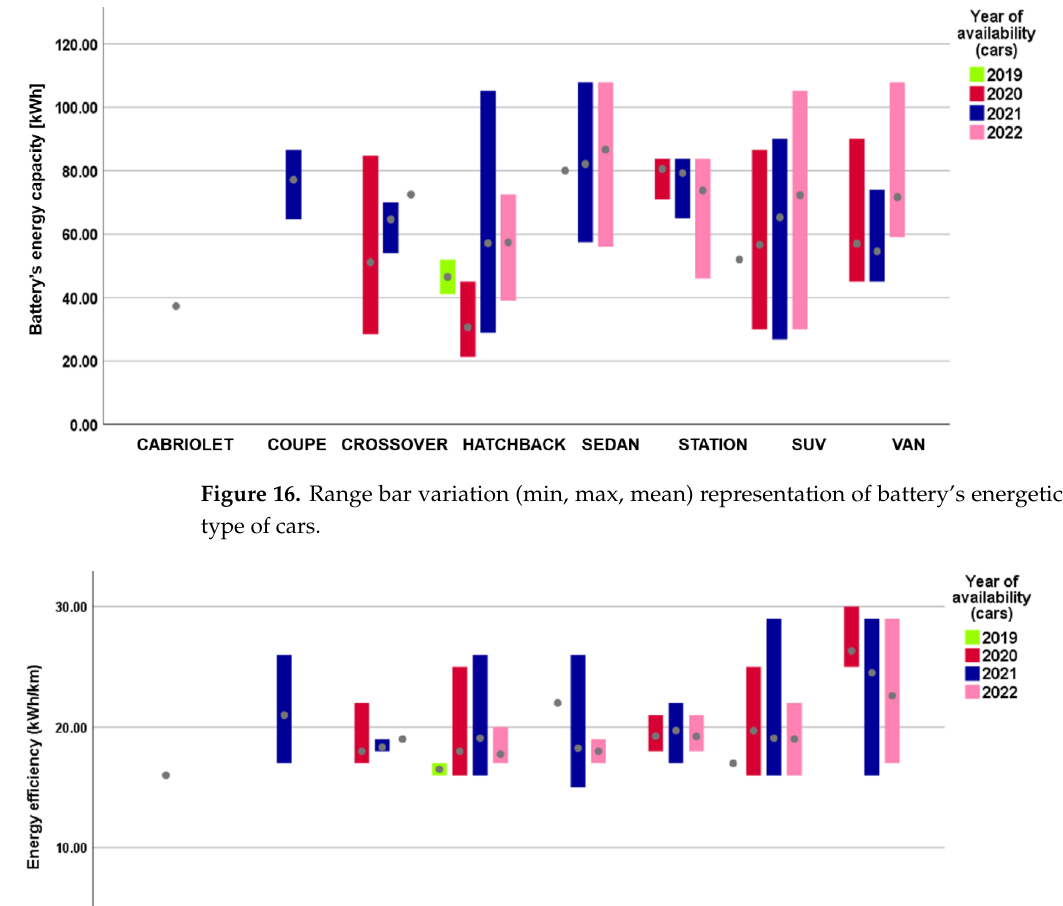
Figure 15. Range bar variation (min, max, mean) representation of autonomy vs. type of cars.